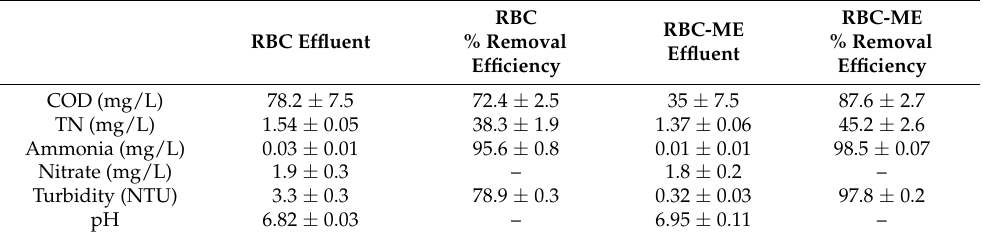
Table 4. Effluent characteristics for the RBC-ME bioreactor employing the PSF membrane in the post-treatment. RBC